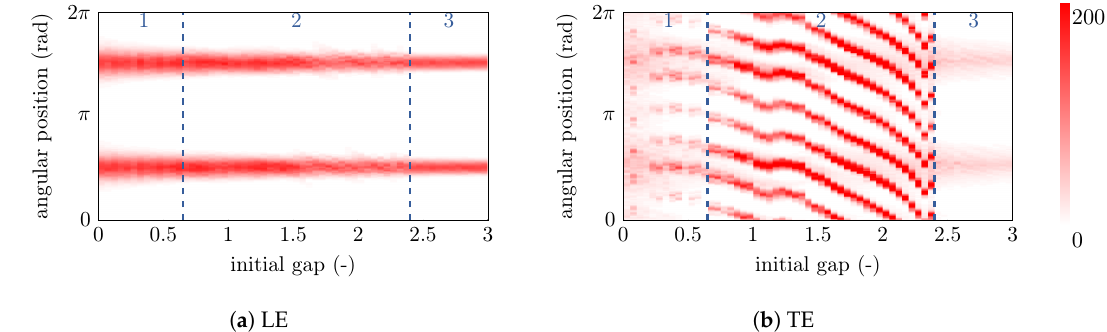
Figure 29. Evolution of the temperature profile with the initial clearance for the LP compressor